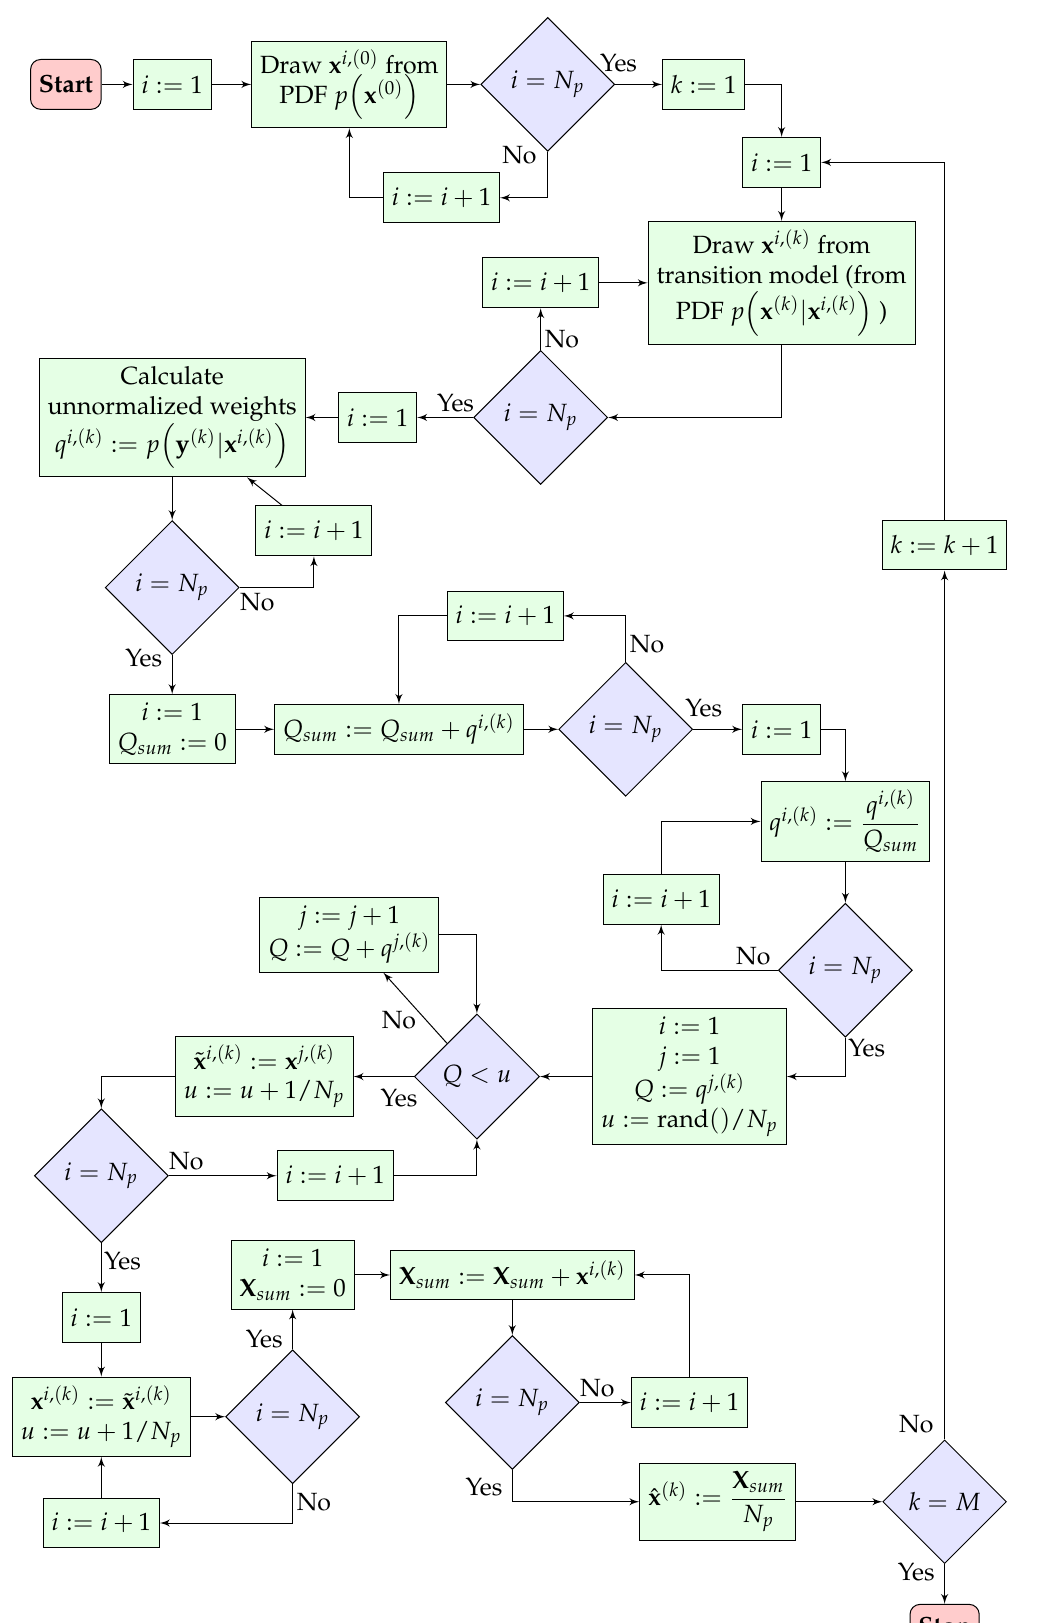
Figure 1. Flow chart of the Bootstrap particle filter algorithm with systematic